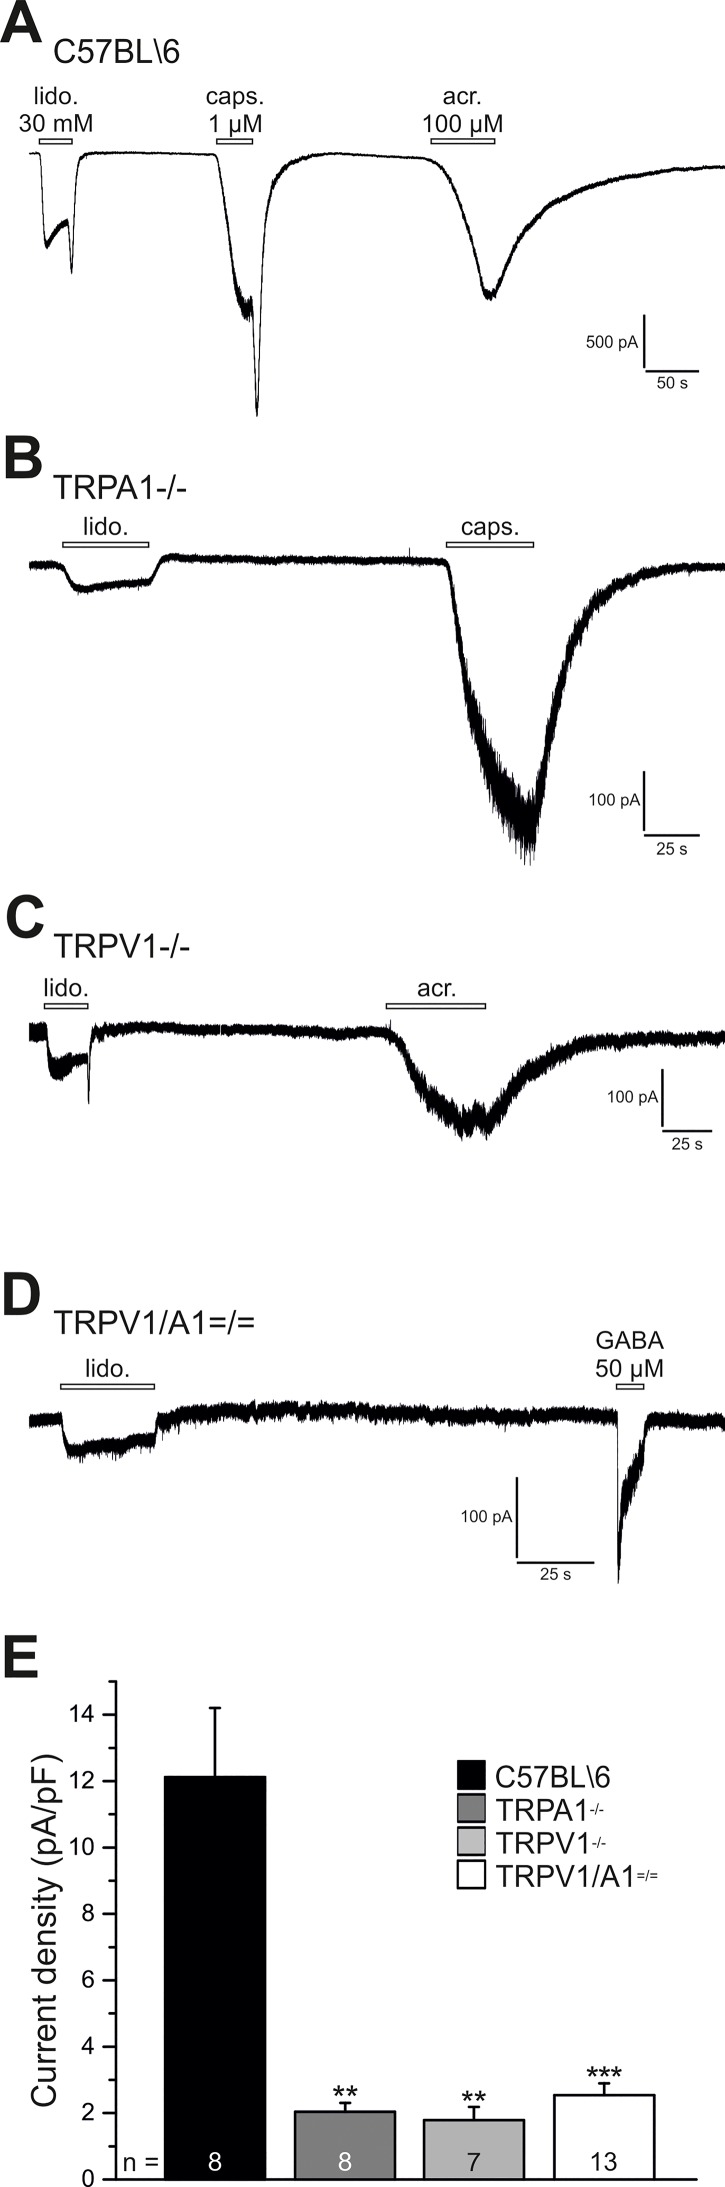
Lidocaine-activated inward currents are mediated by TRPA1 and TRPV1.Representative current traces of whole-cell voltage-clamp recordings from DRG neurons using a holding voltage of– 60 mV. Application of lidocaine 30 mM for 30 s produced inward currents in cells from A. C57Bl/6, B. TRPA1-/-, C. TRPV1-/-, and D. TRPV1/TRPA1 = / = mice. Subsequent application at intervals of 2–3 min of capsaicin (1 μM, 10 s) and/or acrolein (100 μM, 30 s) verified expression of TRPV1 and/or TRPA1 in lidocaine positive neurons. Gamma-aminobutyric acid (GABA, 50 μM, 10 s) was applied comfirming viability of TRPV1/TRPA1 = / = ganglion neurons tested. E. Comprehensive recordings of mean peak currents evoked by lidocaine (30 mM) in C57Bl/6 (black bar), TRPA1-/- (dark grey bar), TRPV1-/- (light grey bar), and TRPV1/TRPA1 = / = (white bar) DRG neurons. The largest lidocaine-activated currents were observed in C57Bl/6 cells (n = 8), while current densities were significantly reduced in all three knockout mice strains to about the same level (TRPA1-/-: p = 0.001, n = 8, TRPV1-/-: p = 0.002, n = 7, TRPV1/TRPA1 = / =: p = 0.0002, n = 13). Results are mean and SEM of mean peak currents by lidocaine. For statistical analysis Mann-Whitney U test was calculated.